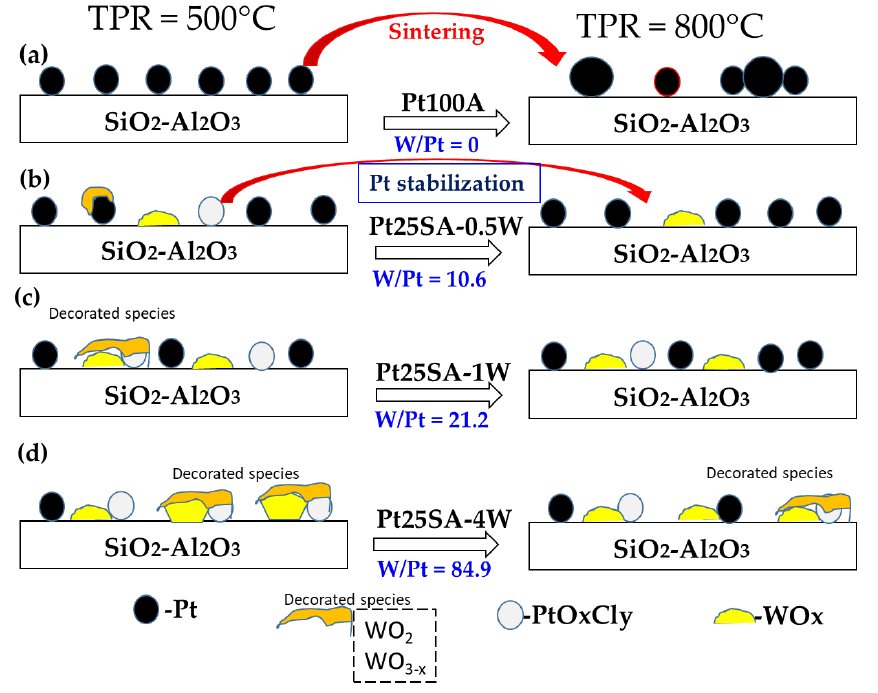
Figure 13. Surface model of the Pt/SiO 2 ‒Al 2 O 3 ‒WO x catalysts: ( a ) Pt100A without WO x , ( b ) Pt25SA‒0.5W, ( c ) Pt25SA‒1W, and ( d ) Pt25SA‒4W.